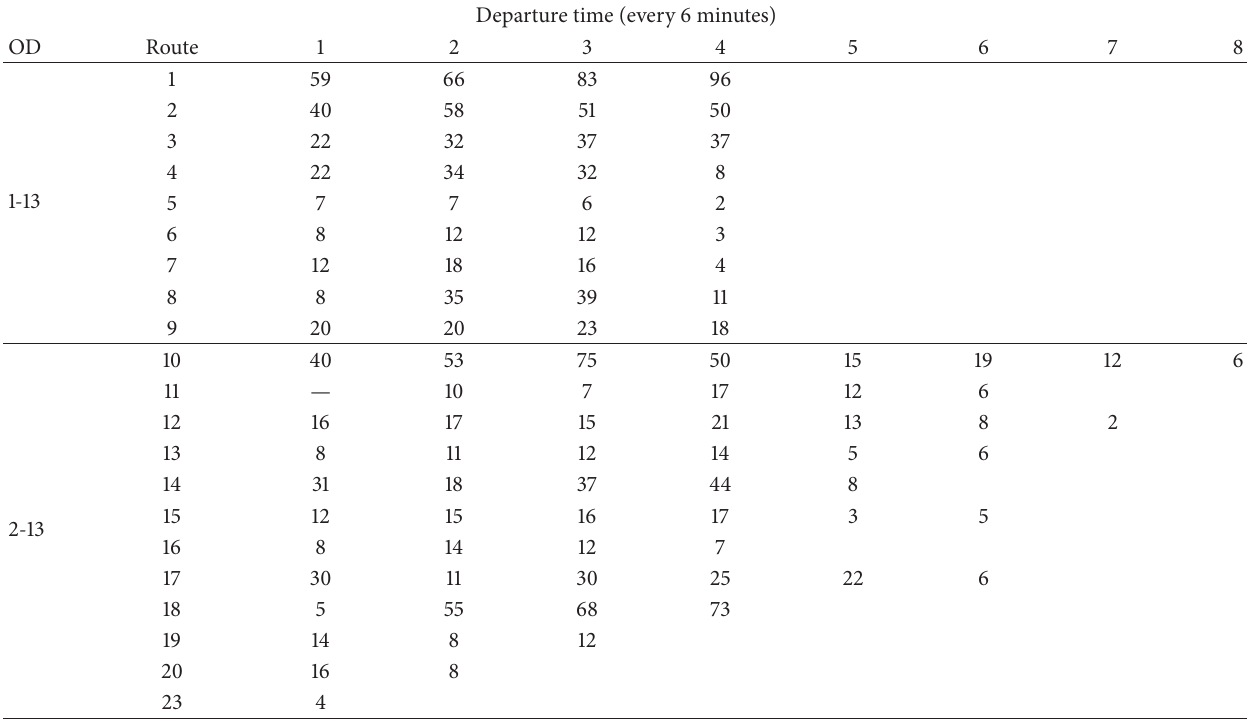
Table 4: Optimal evacuation planning ( 𝐷 1,13 = 1000, 𝐷 2,13 = 1500).